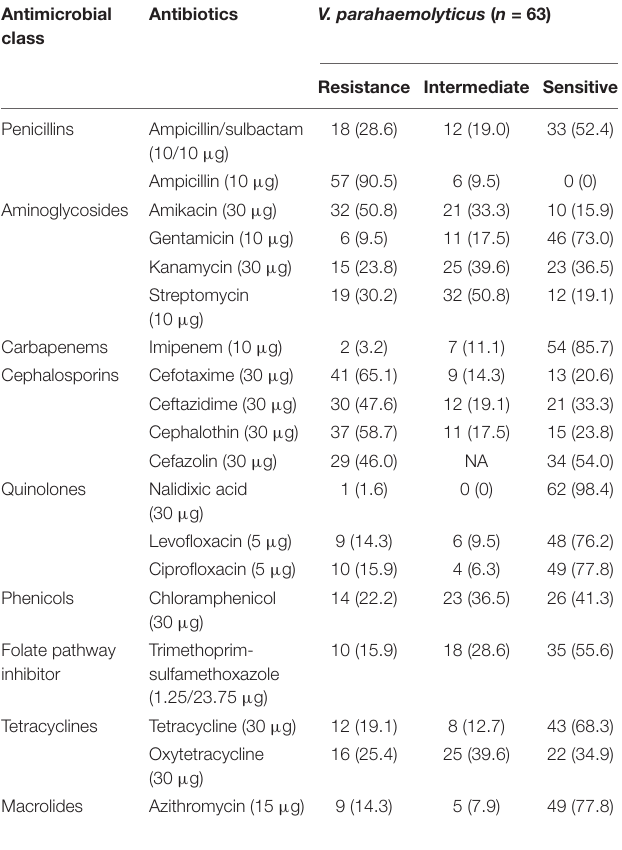
TABLE 1 | Antibiotic susceptibility profile of the V. parahaemolyticus isolates. Antimicrobial